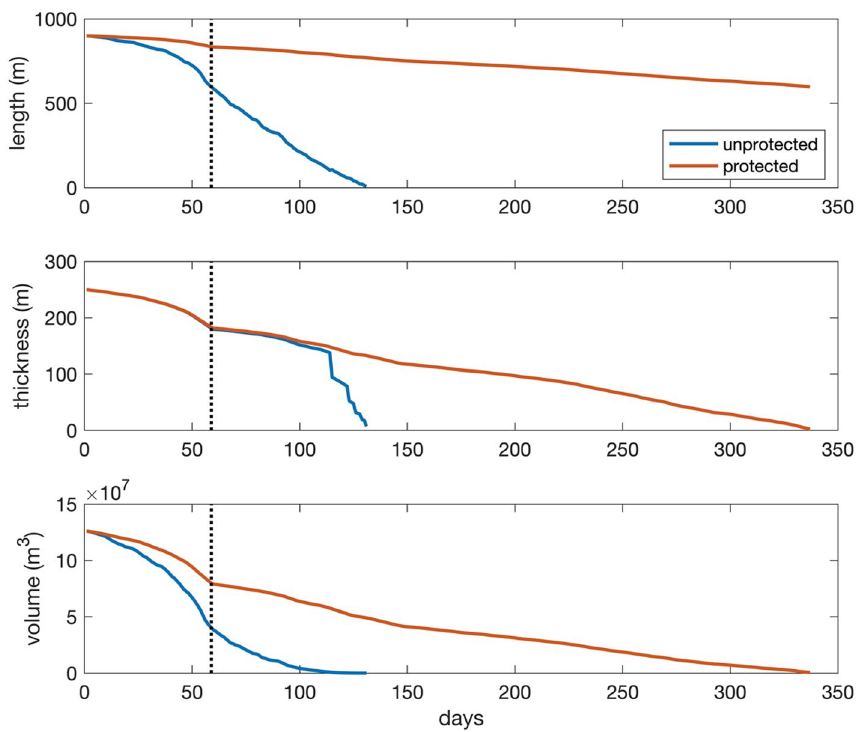
Figure 3. Deterioration of an iceberg 900 m long and 250 m thick towed from Antarctica to Cape Town, South Africa. Protected refers to experiments without wave-induced erosion. The iceberg was towed at 0.5 m/s. The vertical dotted lines denote the day the iceberg arrives at its